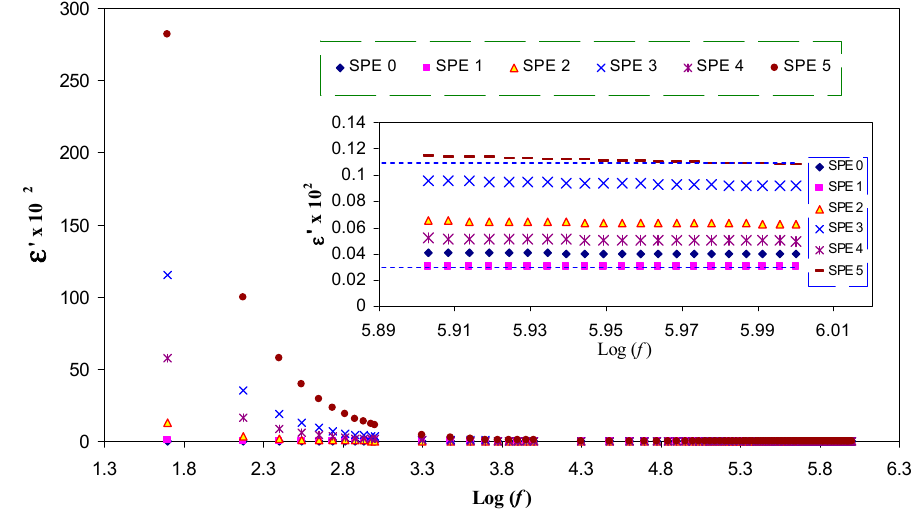
Figure 3. Frequency dependence of dielectric constant for pure PVA and doped PVA samples. The inset shows the dielectric constant for all the samples at high frequencies.